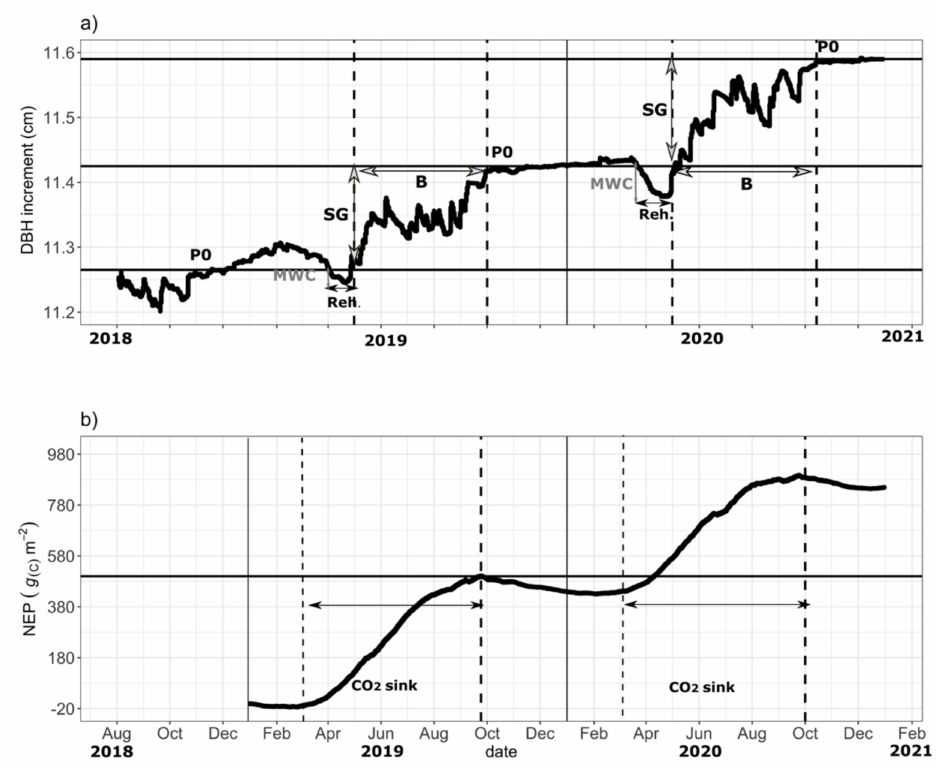
Figure 6. Specific moments and periods of tree growth based on: ( a ) dendrometers and ( b ) eddy covariance measurements. SG—Stem increment over the year, related to seasonal growth, MWC— maximum winter stem contraction, B—wood growth period, P0—the zero-point of the current year that corresponds to the respective culmination point of the past year, NEP-net ecosystem productivity, CO 2 sink-ecosystem productivity over the